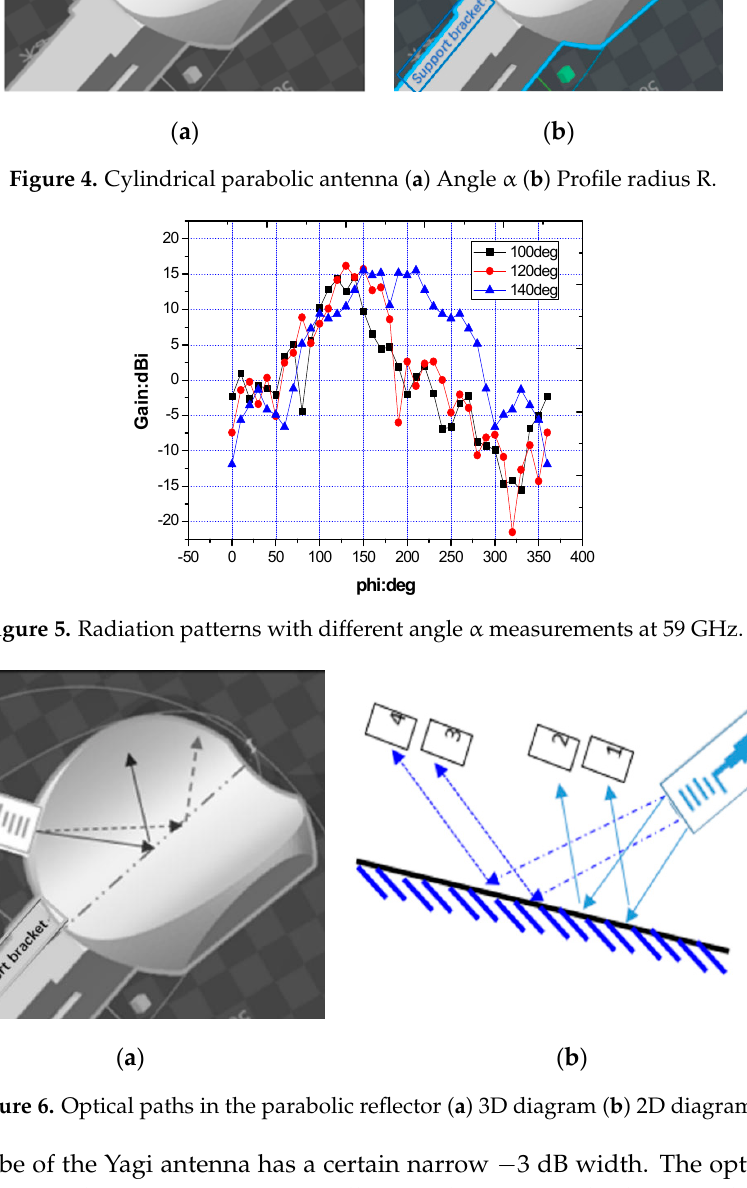
Figure 4 . Cylindrical parabolic antenna ( a ) Angle 𝛼 ( b ) Profile radius R.